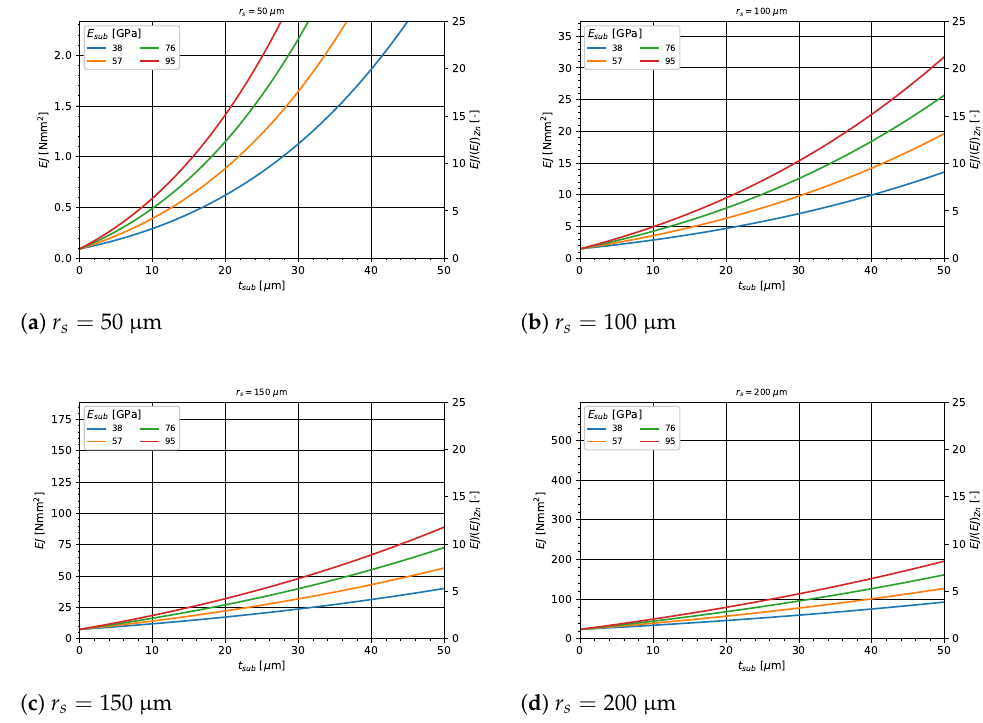
Figure 8. Analytical calculation of the bending stiffness of a single composite strut for varying parameters of the substrate